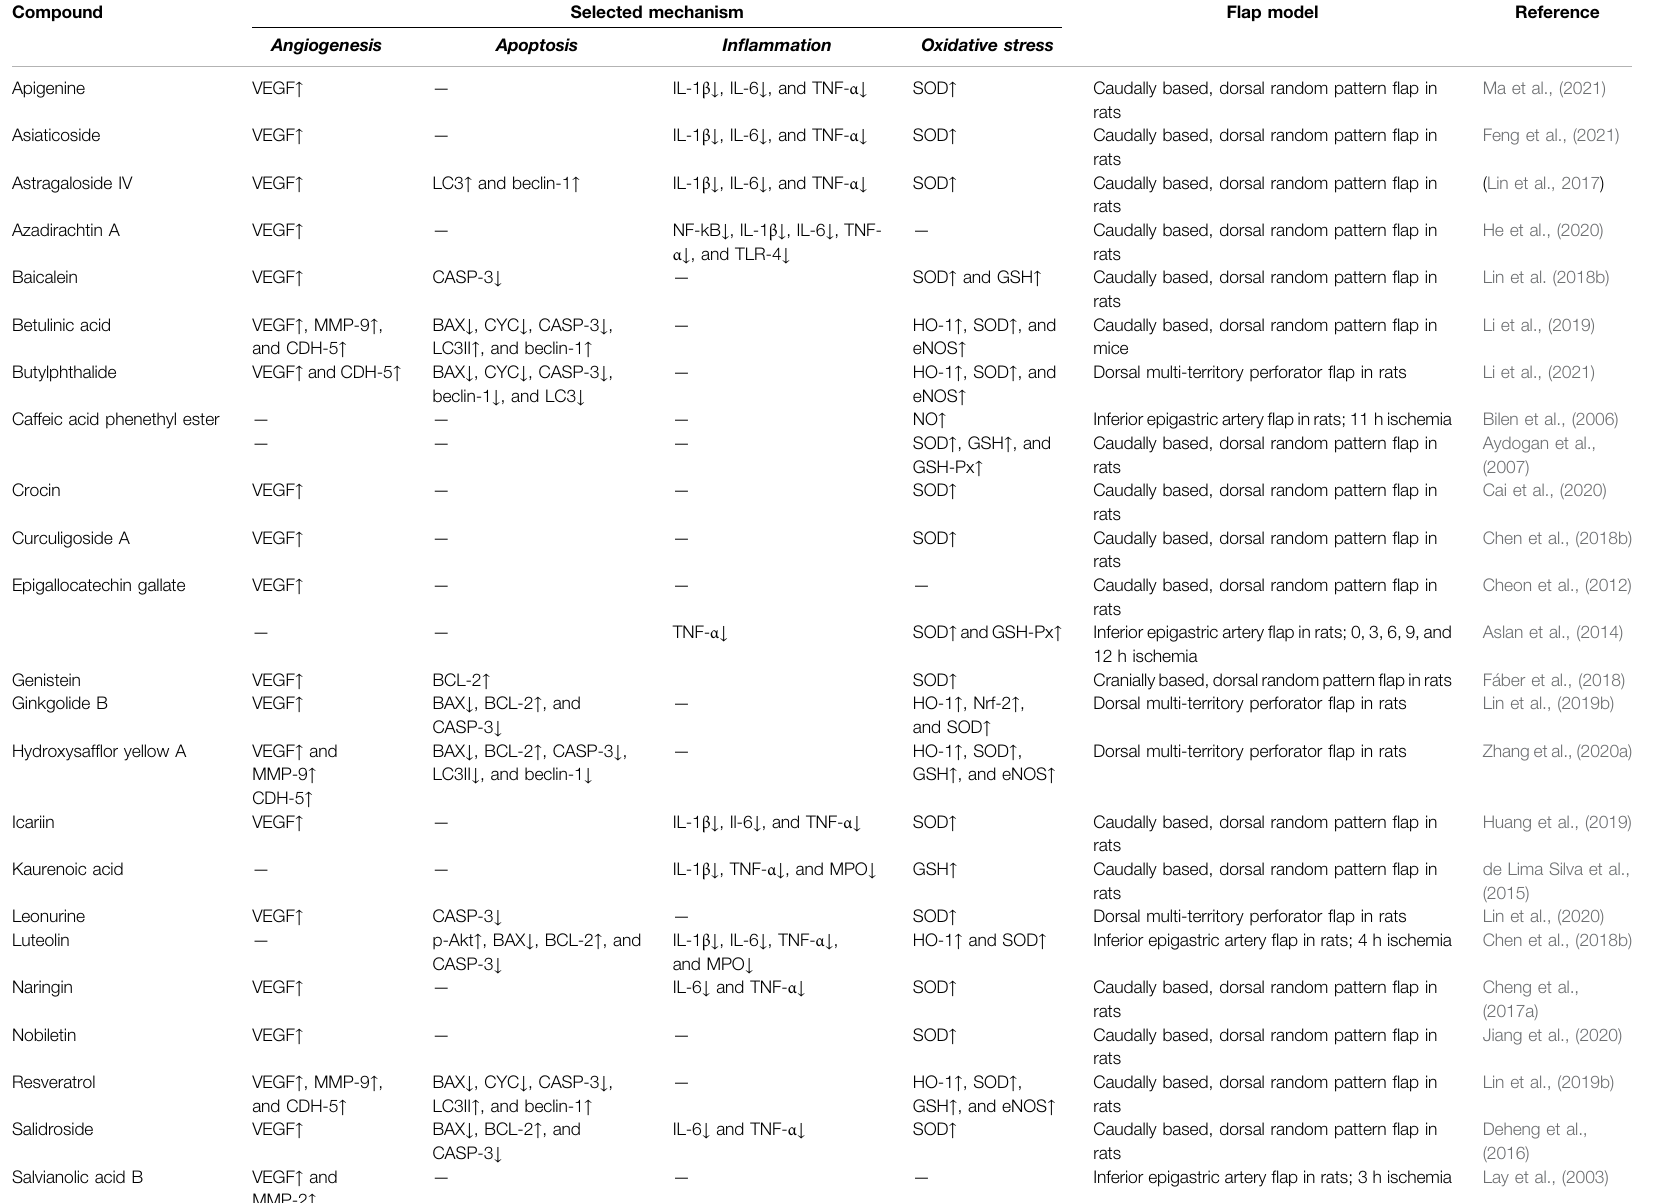
TABLE 1 | Overview of isolated phytochemical compounds and whole plant extracts that have been evaluated in experimental fl ap models. Availability and selected mechanisms mediating their effects are